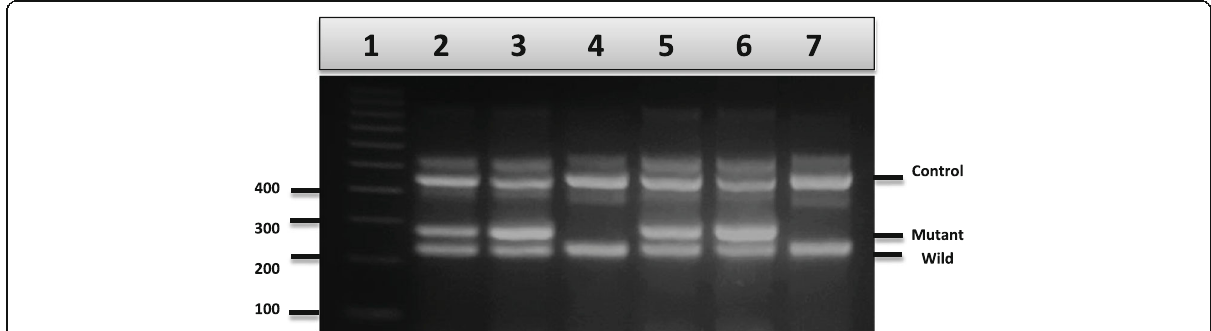
Fig. 2 Electrophoresis of amplified PCR products to detect JAK2 p. Val617Phe pathological variant in MPNs by ARMS technique. ARMS PCR shows an internal control band at 463 bp; the 229-bp band indicates the presence of the wild allele and the 279-bp band indicates the presence of the JAK2 p. Val617Phe mutant allele. Left to right: lane 1 is 100-base pair (bp) DNA ladder and lanes 2, 3, 5, and 6 are JAK2 p. Val617Phe positive while lanes 4 and 7 are wild type